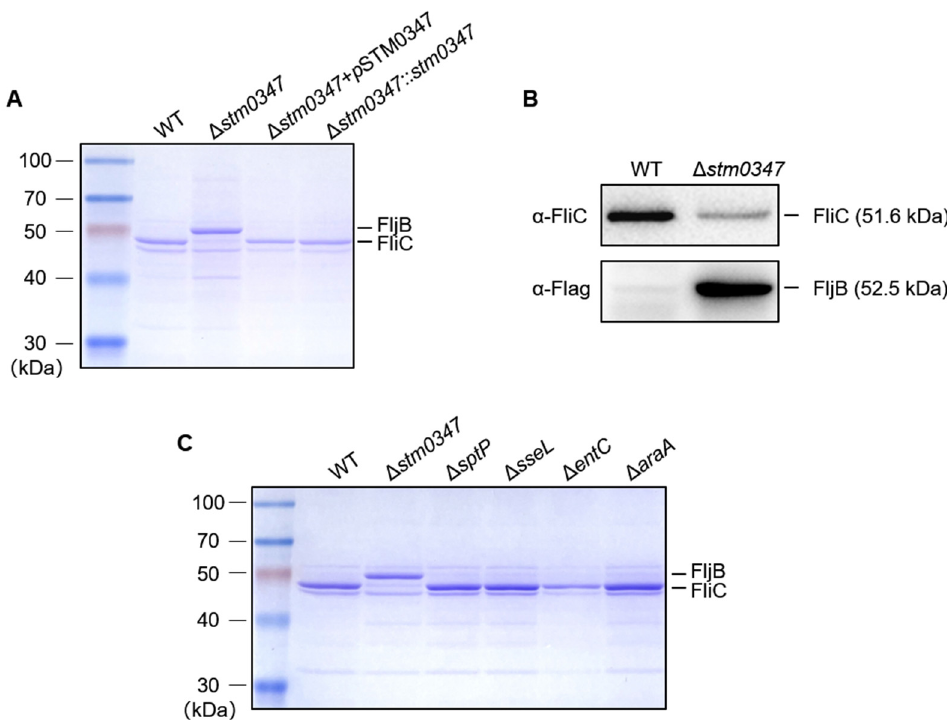
Figure 3. STM0347 regulates flagellin phase variation in S. Typhimurium. ( A ) Secreted proteins in the wild-type strain, the stm0347 deletion mutant strain, the ∆ stm0347 complemented with an STM0347-expressing plasmid strain, and the ∆ stm0347 chromosomally complemented with stm0347 coding sequence strain, were visualized with Coomassie blue strained gel. ( B ) Protein levels of FliC and FljB in secreted proteins of the WT and stm0347 deletion mutant strain, determined with Western blot. ( C ) Secreted proteins in the WT strain, the stm0347 deletion mutant strain, and the sptP , sseL , entC , and araA deletion mutant strain were visualized with Coomassie blue strained gel. 2.4. ∆ STM0347-Induced Flagella Phase Variation Depends on the Modulation of